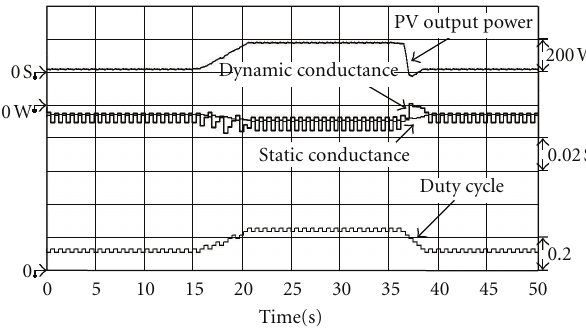
Figure 12: Simulated output power, dynamic conductance, static conductance, and sduty cycle waveforms of a PV module array using the traditional INC method under irradiation that increased from 450 W/m 2 to 750 W/m 2 and then dropped back to 450 W/m 2 .